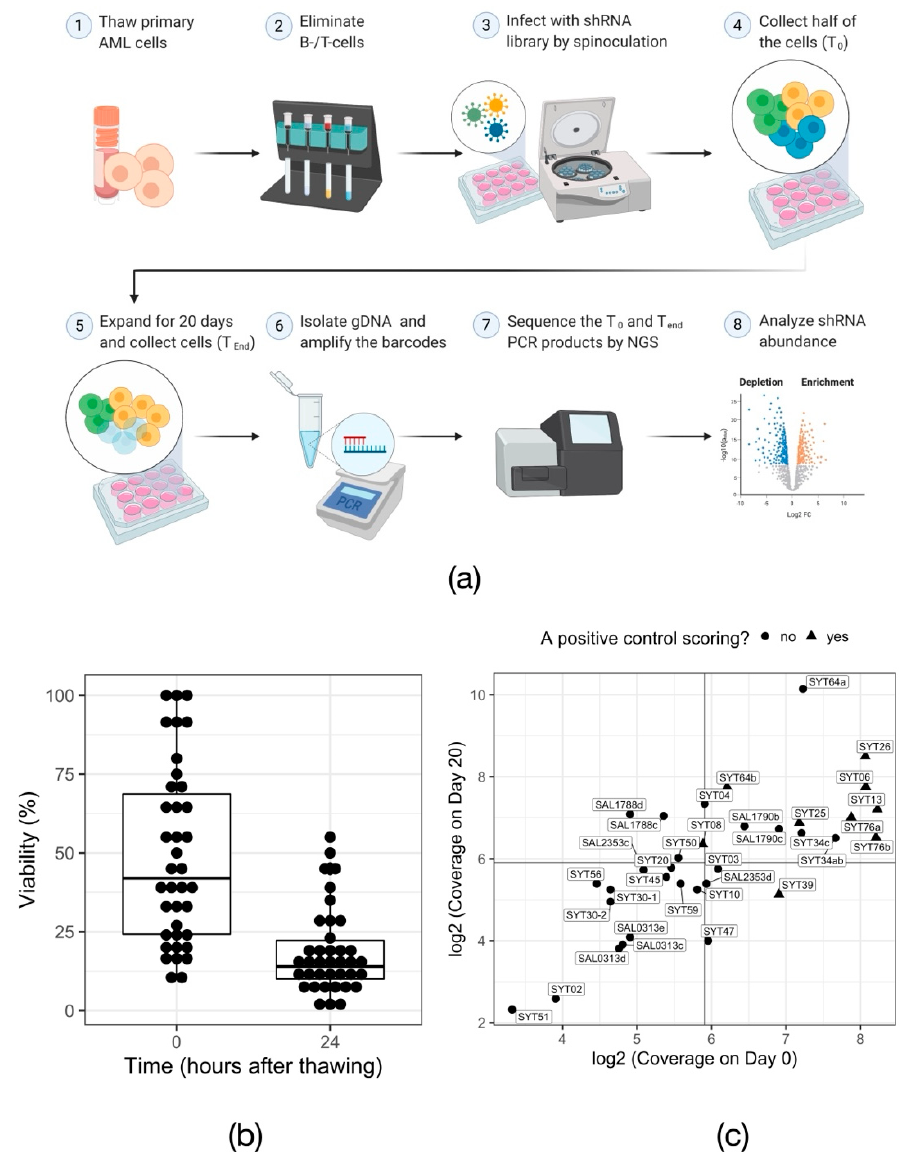
Figure 2. RNAi screen in primary AML samples. ( a ) Overview of the experimental procedure for RNAi-mediated in vitro screening of primary AML cells. Created with BioRender.com ( b ) Cell viability measured via trypan blue exclusion assay immediately after thawing of the samples (0 h) and after overnight cytokine induction (24 h). Each data point represents one primary AML sample. ( c ) Dot plot visualizing the shRNA representation, calculated based on the number of cells collected for gDNA isolation, in every primary sample at the beginning (Day 0) and the end (Day 20) of the screen. Solid lines mark the arbitrary threshold of 60× representation.